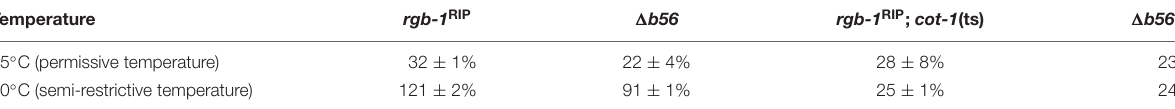
TABLE 3 | Radial growth rate of rgb-1 RIP ; cot-1 (ts) and (cid:49) b56 ; cot-1 (ts) strains after 44 h (percent of cot-1 (ts) growth). Temperature rgb-1 RIP (cid:49) b56